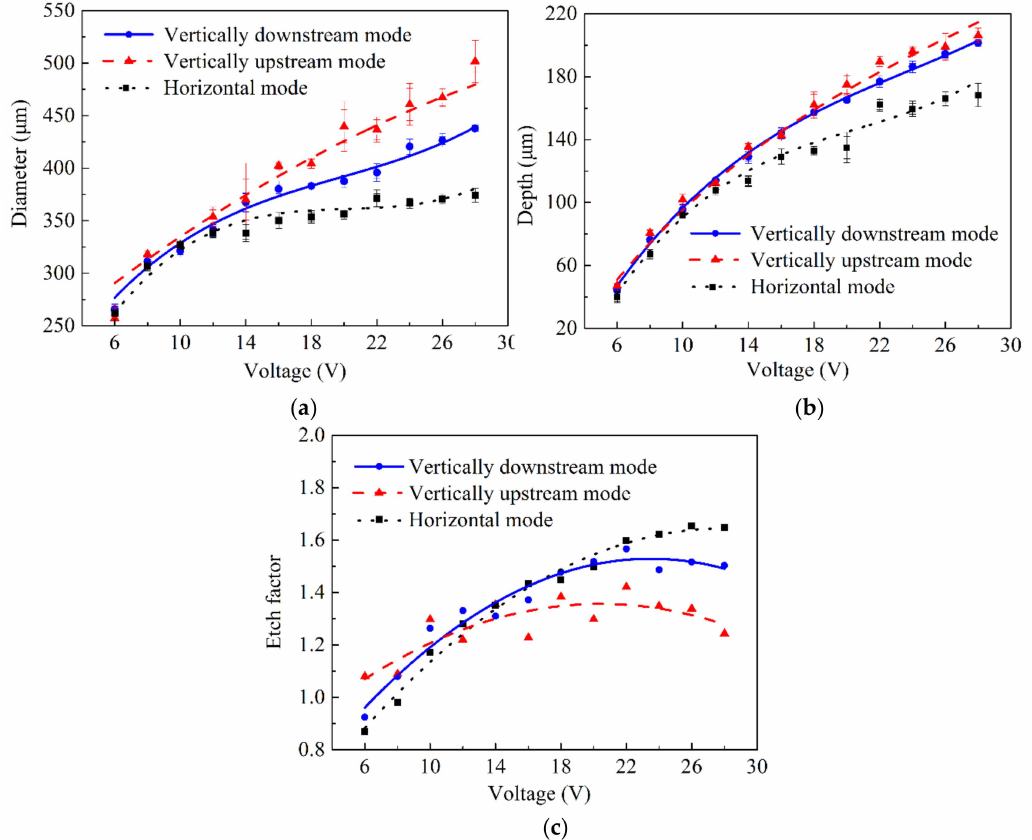
Figure 11. Change of the geometric dimensional sizes (diameter, depth, etch factor) of the machined micro-dimples with the applied voltage when the nozzle’s inner diameter was 170 µ m and working gap was 100 µ m. ( a ) Diameter; ( b ) depth; ( c ) etch